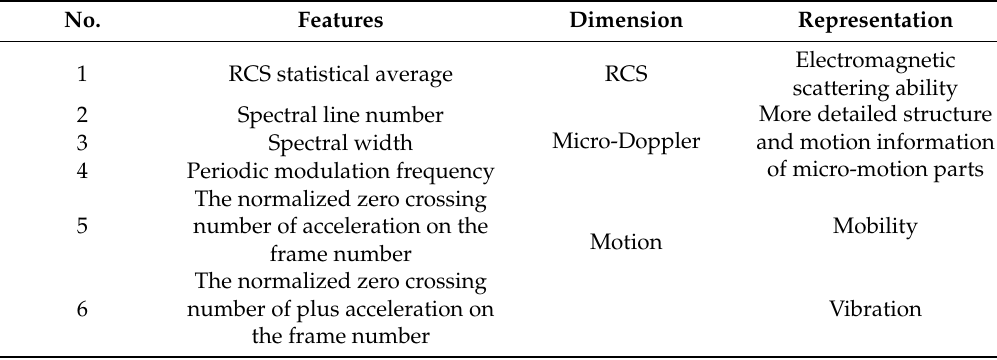
Sensors 2019 , 19 , x FOR PEER REVIEW 11 of 22 reflect the electromagnetic scattering characteristics and posture characteristics of the targets; the micro-Doppler spectrum reflects more details of micro-motion parts of the targets; and the motion